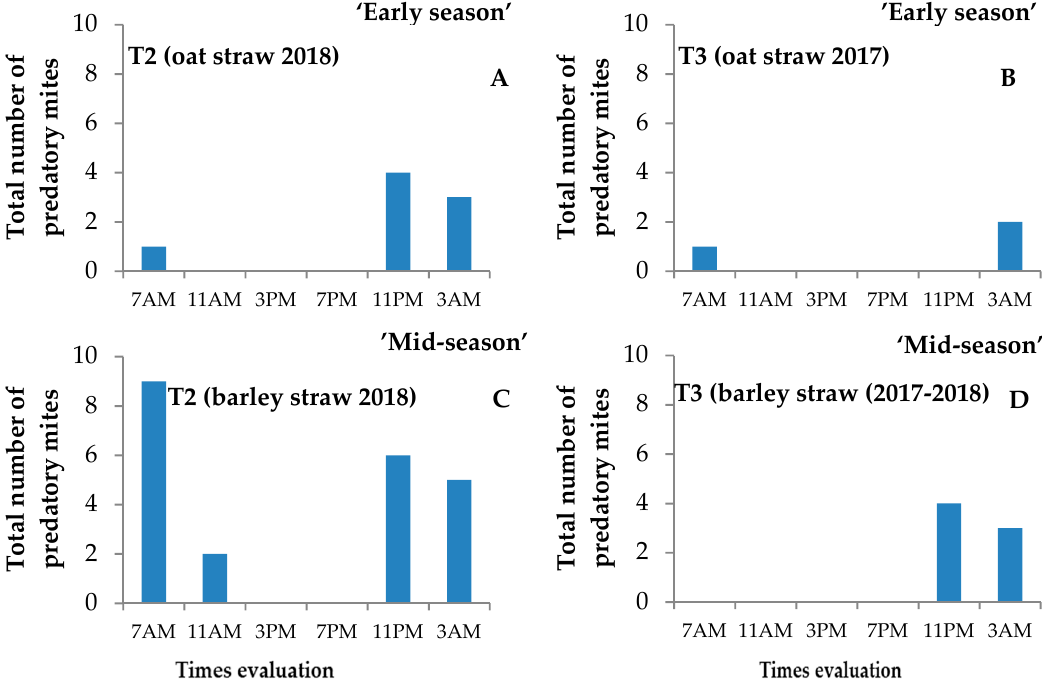
Figure 1. Weekly total numbers of Gamasina mites observed on six marked leaflets with Tetranychus urticae per plant ( n = 13 plants per treatment). A and B : ‘Early season’ experiment (T2, oat straw since 2018; T3, oat straw since 2017); C and D : ‘Mid-season’ experiment (T2, barley straw since 2018; T3, barley straw lower half layer since 2017 and top half layer since 2018). Light was on from 6 AM to 9 PM.